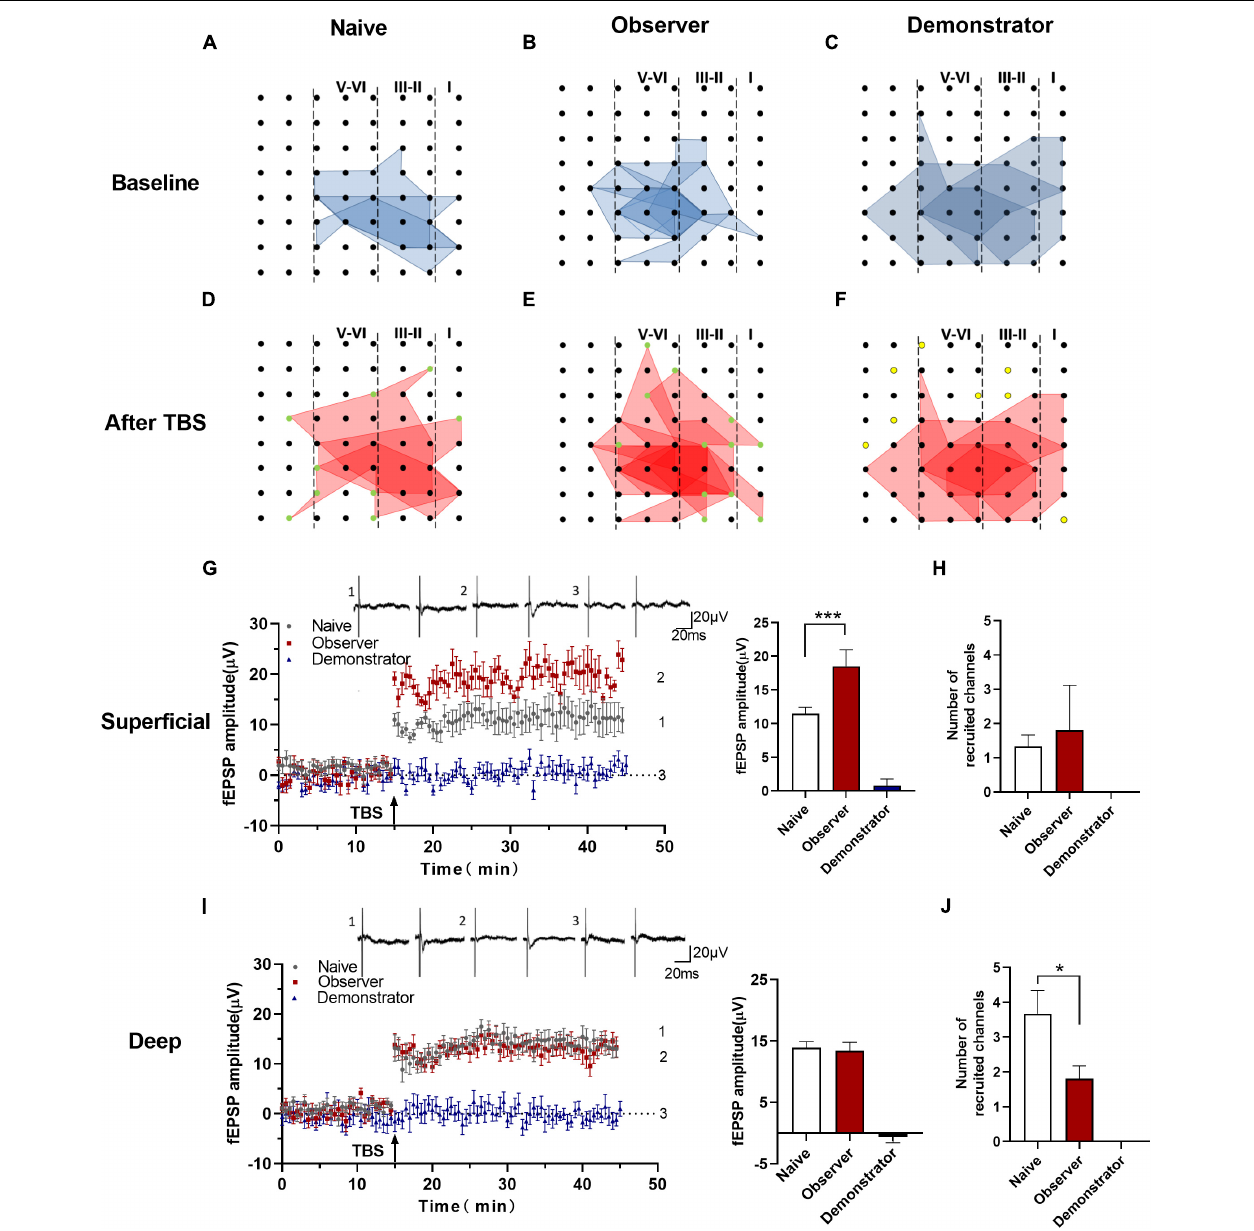
FIGURE 5 | Recruited responses in the aIC of observer after TBS. (A–F) The network propagation of synaptic responses in aIC after TBS of naïve (A,D) , observer (B,E) , and demonstrator mice (C,F) . Basal activated areas (blue), and recruited areas (red), and the recruited channels are shown as green spot, channels out of the edge of the activated channels in demonstrator mice are shown as yellow spot; (G,I) Left: Time course of averaged fEPSP amplitude of recruited channels from the superficial (G) and deep layers (I) in naïve and observer mice and the no responses channels in demonstrator mice. The arrow indicates the time of TBS application in the deep layer V/VI; Right: the average fEPSP amplitude of the channels within the last 10 min recording in the superficial (G) and deep layers (I) ; (H,J) Average number of channels of naïve and observer in the superficial (H) and deep layers (J) . Data are shown as mean ± SEM (naïve n = 3 slices of 3 mice, observer n = 6 slices of 6 mice, and demonstrator n = 4 slices of 4 mice) and compared by unpaired t -test with Welch’s correction, * p < 0.05, *** p < 0.001, vs. naïve.